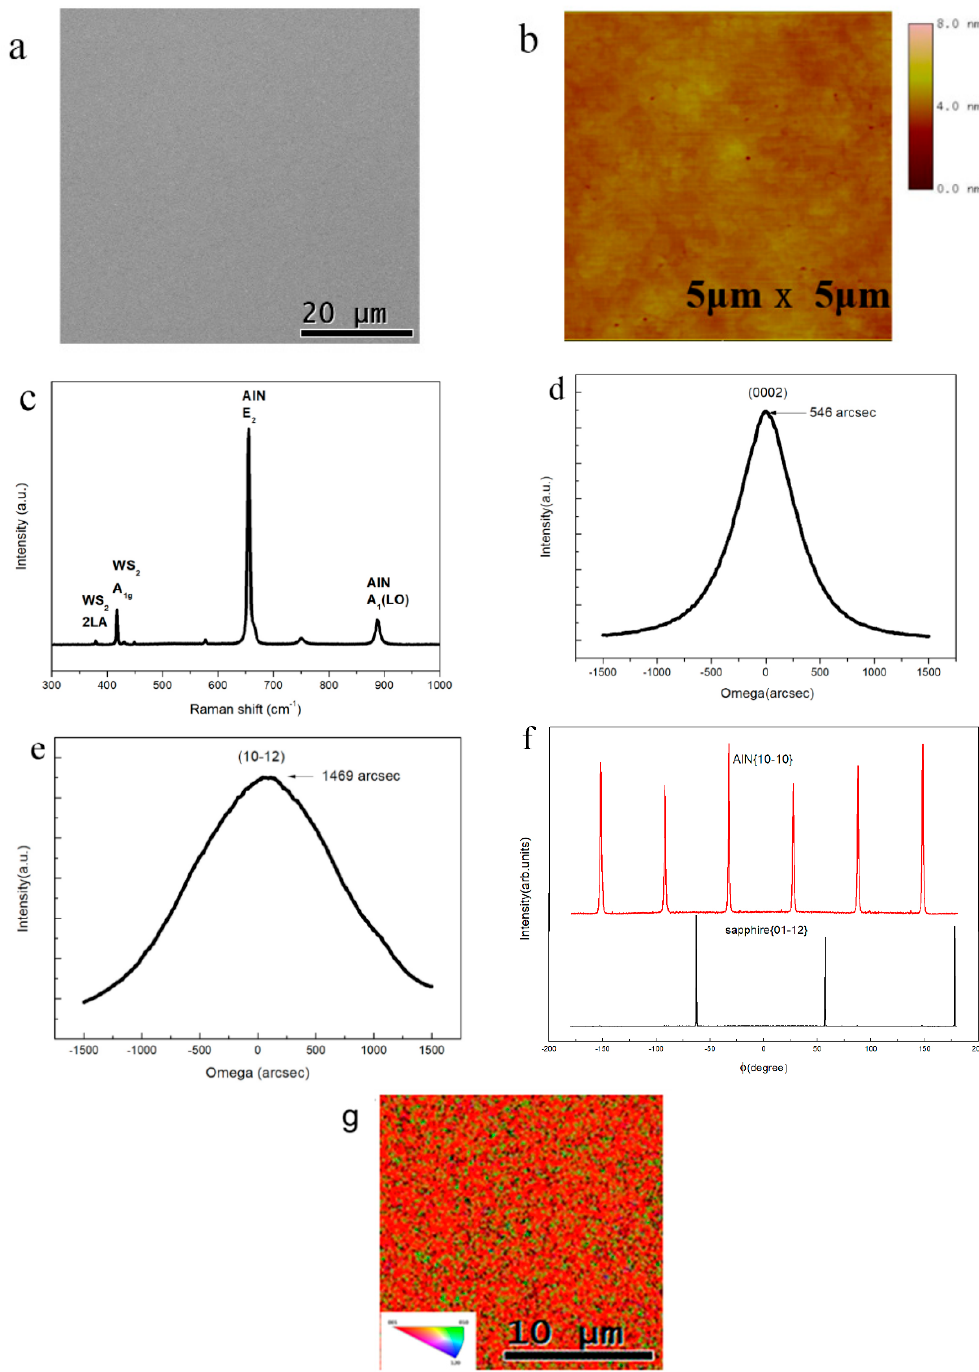
Figure 2. Characterizations of AlN thin film growth on WS 2 /sapphire substrate without extra treatment. ( a ) SEM image, ( b ) AFM image, ( c ) Raman spectra, ( d ) X-ray rocking curves of (0002), and ( e ) (10-12) of the AlN film grown on sapphire with WS 2 interlayers. ( f ) X-ray powder diffraction (XRD) ϕ scan curve with 2 θ = 25.58 ◦ χ = 57.61 ◦ . ( g ) Electron backscatter diffraction (EBSD) mApping of AlN